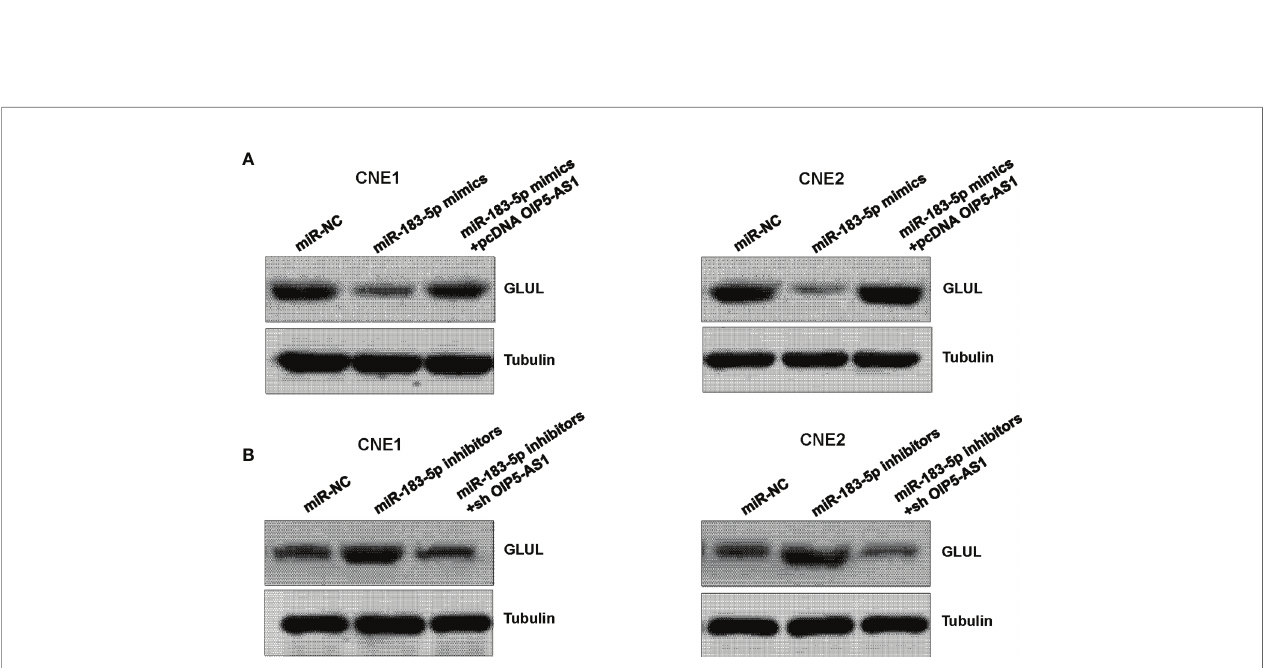
FIGURE 4 | GLUL is a target of miR-183-5p. (A), Western blotting assay was performed to measure the expression of GLUL in NPC cells after miR-183-5p mimic and pcDNA OIP5-AS1 co-transfections. (B), Western blotting analysis was used to measure the expression of GLUL in NPC cells after miR-183-5p inhibitor and shRNA OIP5-AS1